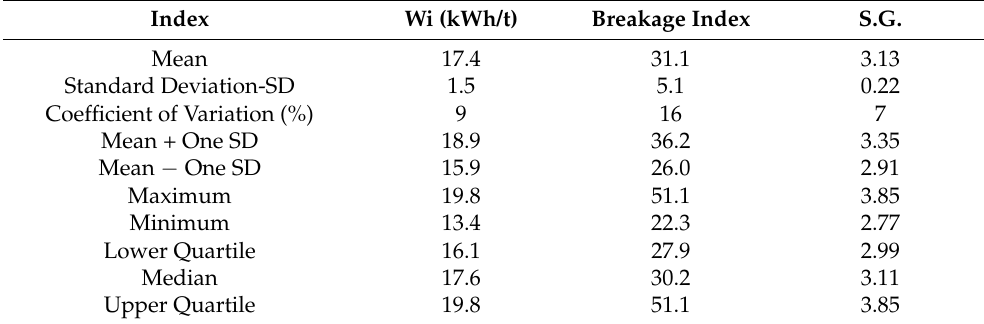
Table 1. Summary of characterization test results.